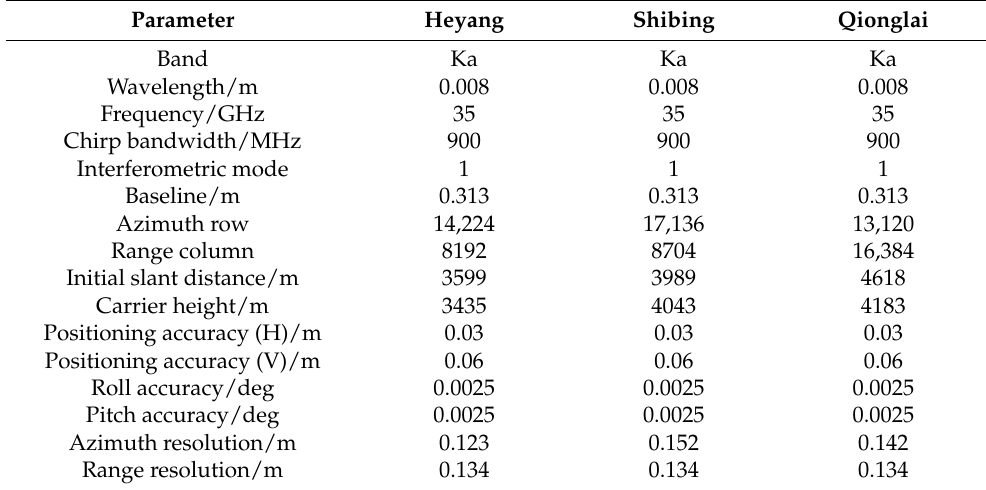
Table 1. Experimental parameters of the airborne InSAR system.